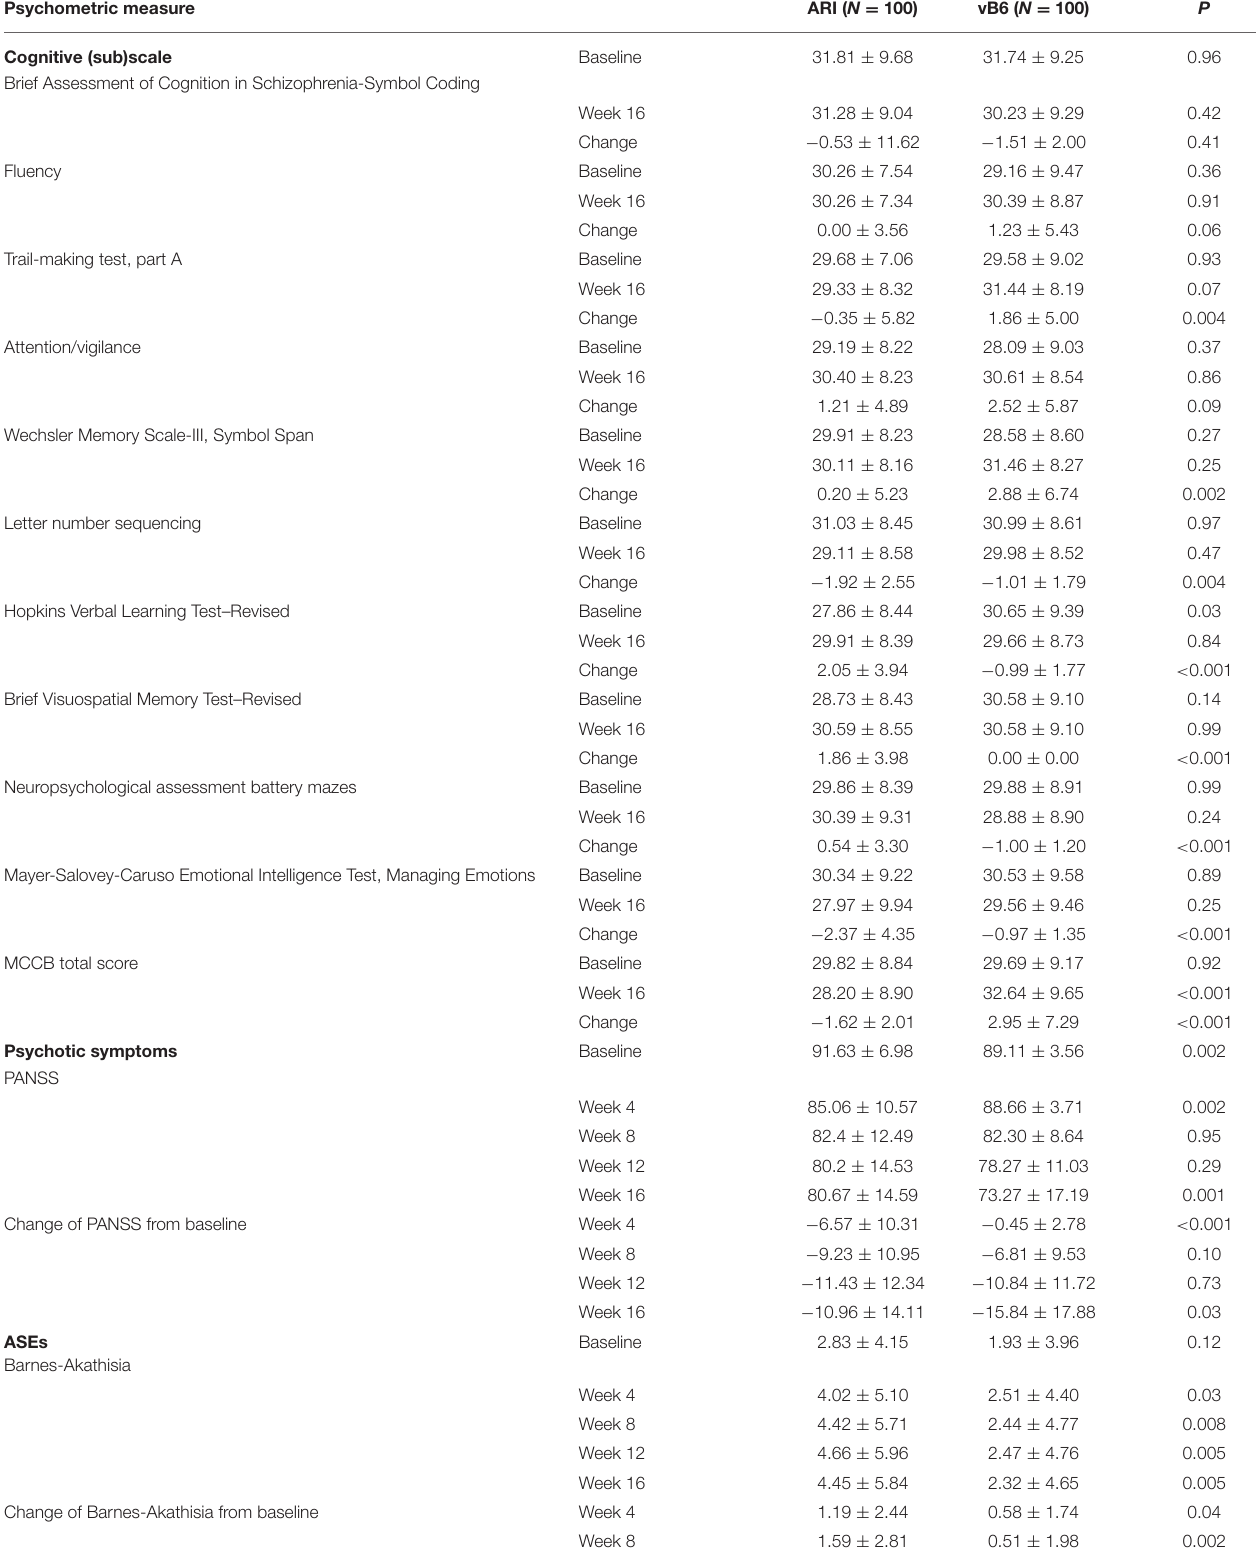
TABLE 4 | Cognitive, psychotic symptom and ASE scores at baseline and after 16 weeks in patients with TRS. Psychometric measure ARI ( N = 100) vB6 ( N = 100)